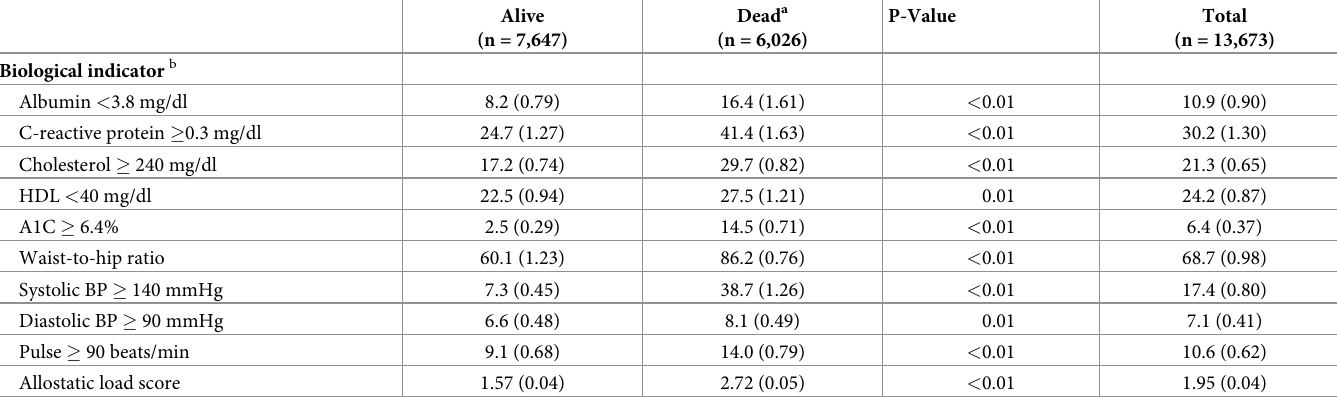
Table 3. Descriptive statistics for biomarkers and allostatic load score for adults 25 years of age or older: NHANES III-Linked Mortality File, 2015.